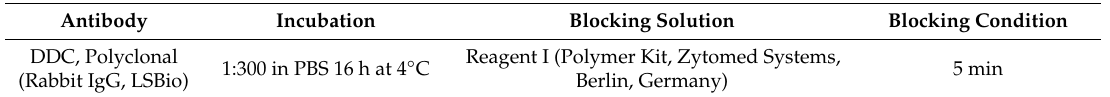
Table 2. Features of the antibodies used for